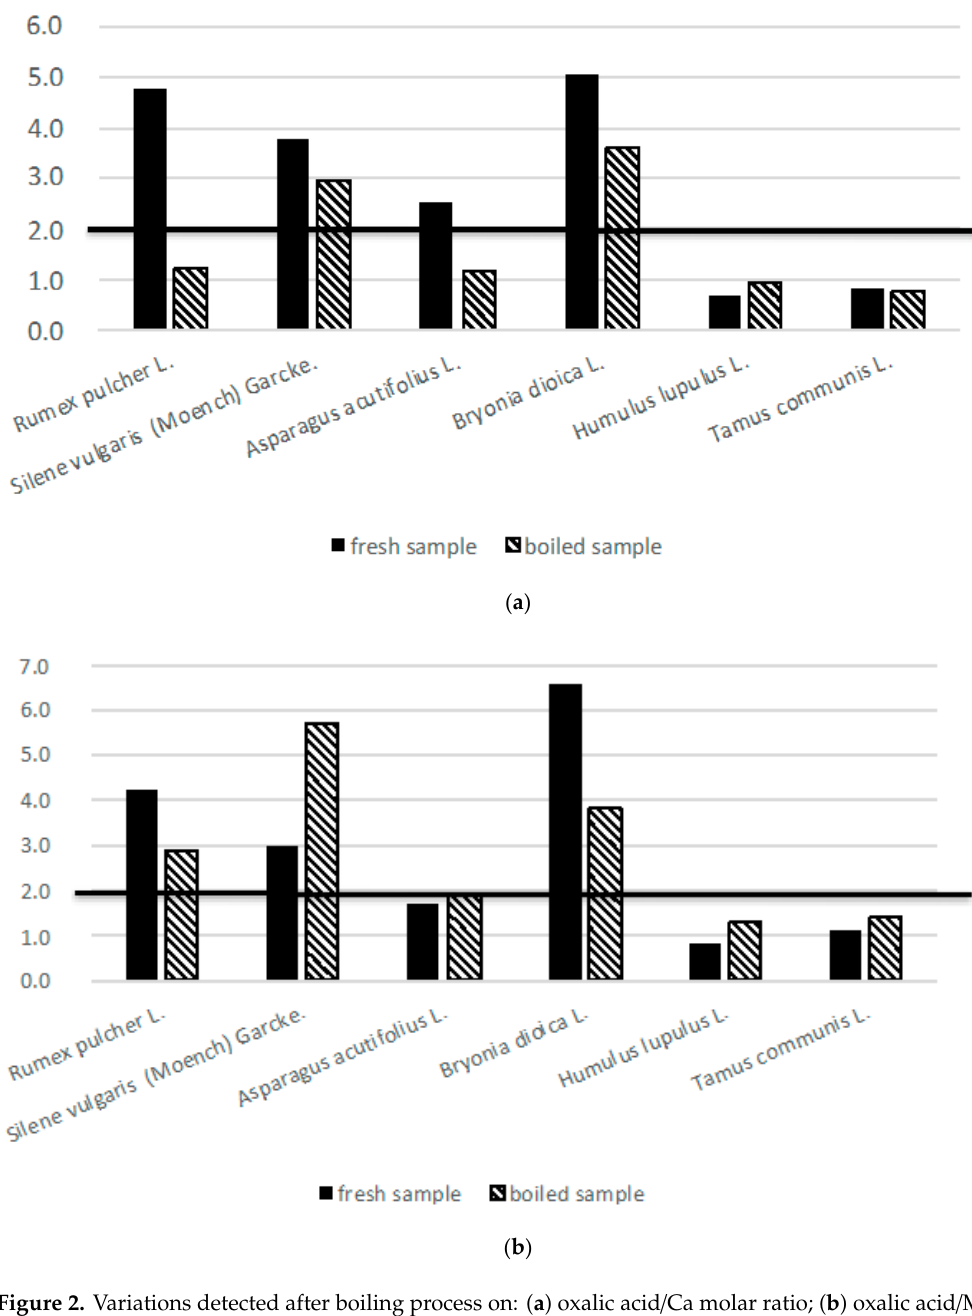
Figure 2. Variations detected after boiling process on: ( a ) oxalic acid/Ca molar ratio; ( b ) oxalic acid/Mg molar ratio.